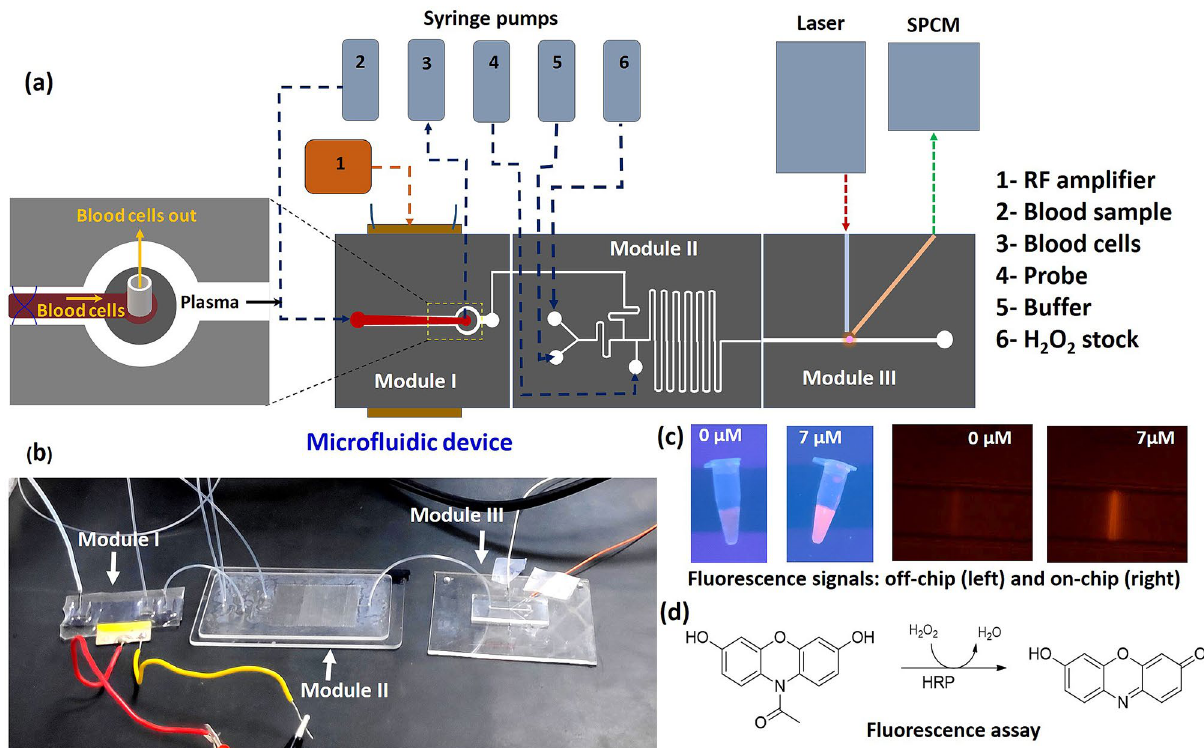
Figure 1. ( a ) Schematic of the integrated microfluidic device with the different modules (module I—blood plasma separation, module II—mixing and incubation, and module III—optical detection) and experimental setup, ( b ) photograph of the actual device showing the different modules, ( c ) Representative images showing FL signals from H 2 O 2 + probe mixture in Eppendorf tube and microchannel and, ( d ) Probe